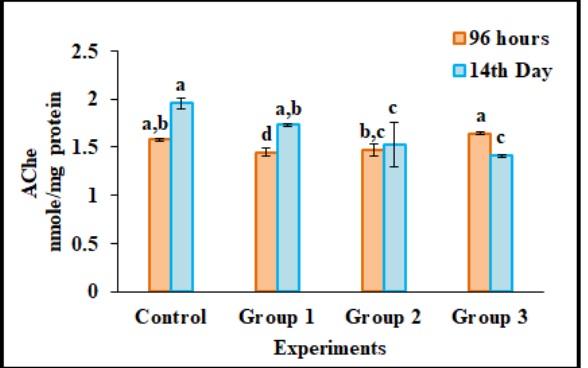
Figure 4. Neurotransmitter enzyme acetylcholinesterase activity (AChE) in brain tissues of Oreochromis mossambicus after 96 h and 14 days of dietary exposure to polypropylene microplastics at different concentrations (100 mg/kg (Group 1), 500 mg/kg (Group 2), 1000 mg/kg (Group 3)). Statistically significant differences ( p < 0.05) between experimental groups correspond to different alphabet letters. (Duncan ’ s multiple ranges test significant value p < 0.05).